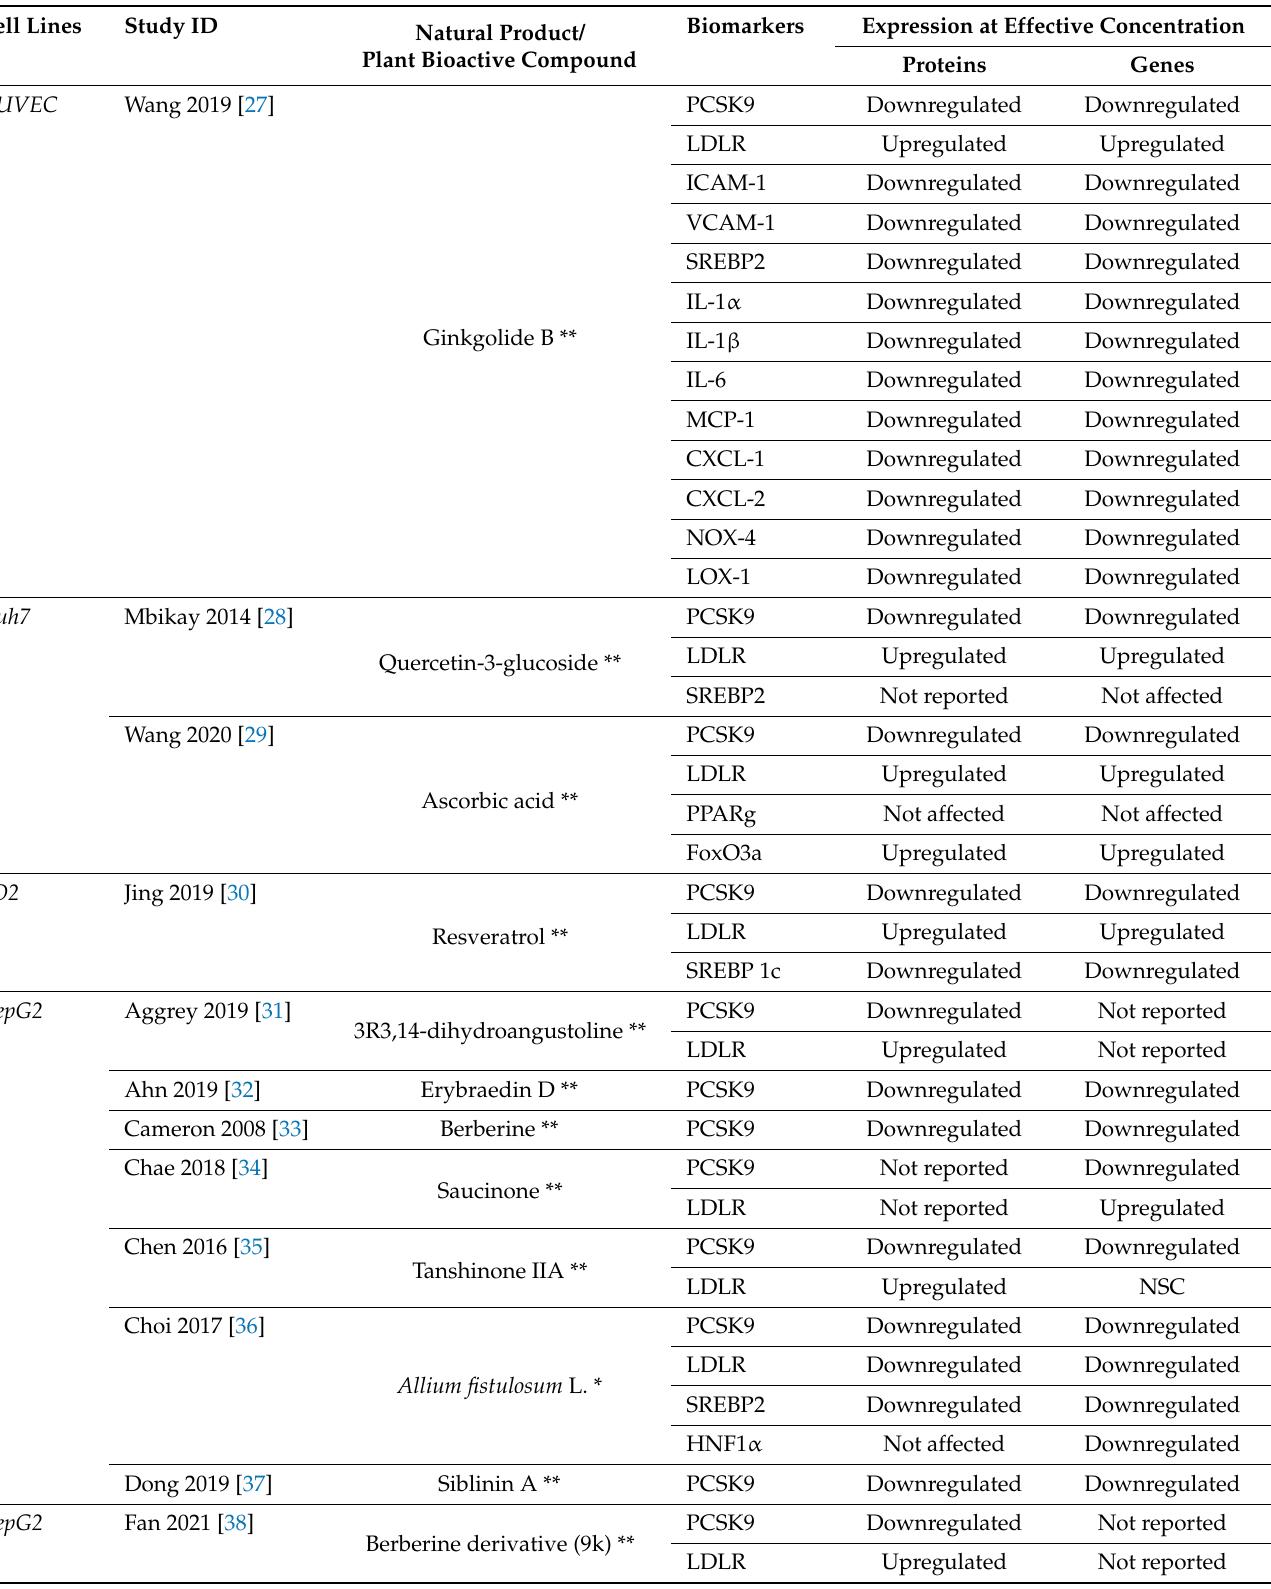
Table 1. Summary of biomarkers expression of selected